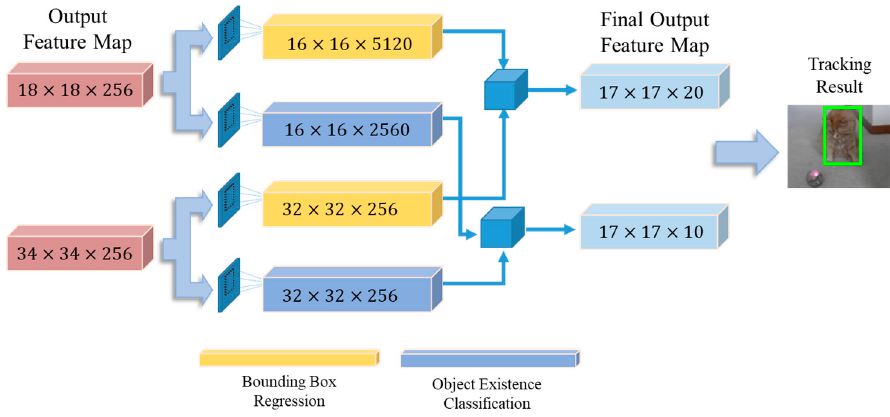
Figure 7. Proposed RPN Architecture.